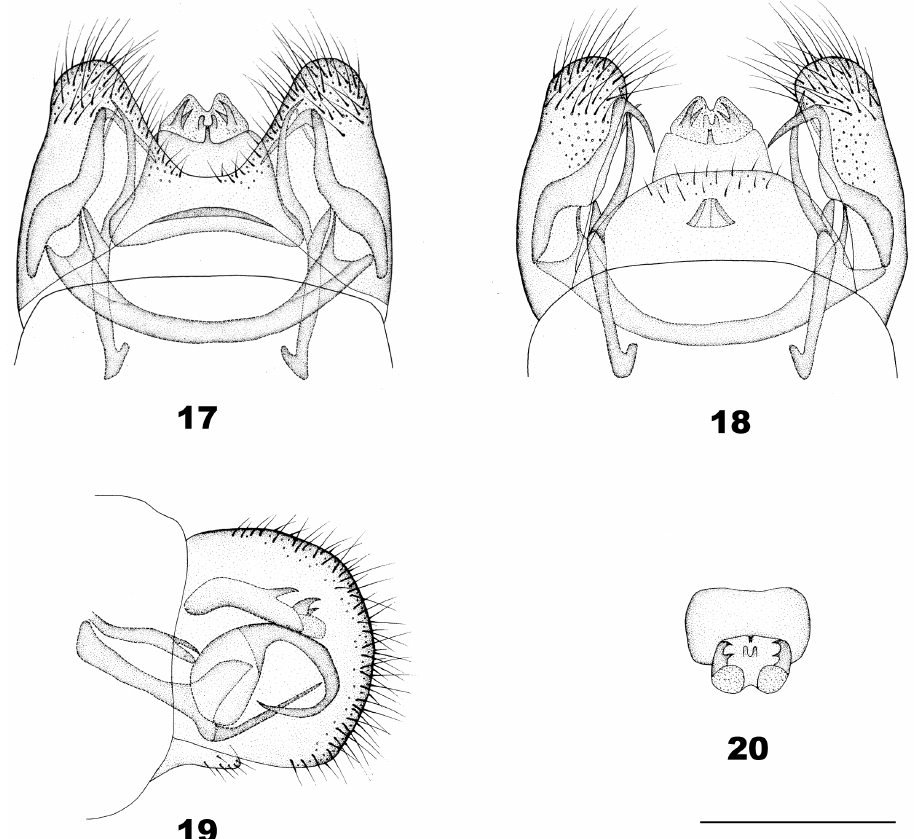
Head yellowish brown, with pale yellow setose tuber- cles. Compound eyes blackish brown. Antenna with ca. 25 segments, pale yellowish brown, medial flagellomeres much longer than those on both ends, distal eight flagel - lomeres short, nearly moniliform. Prothorax pale yellowish brown, pronotum dark brown, with eight yellowish tubercles clothed with yel- lowish hairs; mesothorax and metathorax pale yellowish brown. Legs pale yellowish brown, with each segment blackish brown at tip. Wings hyaline, slightly pale brown, with numerous brownish spots. Forewing ~2.5 times as long as wide, densely spotted, most spots expanded and fused with each other, with markings on costal area and proximal half much darker, arranging as transversely ar- cuate pattern, an immaculate area present distal to median nygmata; two nygmata present on proximal and median portion of forewing, median one much larger than prox- imal one. Hindwing slightly paler than forewing, with similar marking pattern; one nygma present at middle. Veins brown. Forewing with 13 crossveins between Sc and R; Sc just touching R in pterostigmatic region; 12 crossveins between R and Rs; Rs with five main branch - es; MP with two main branches. Hindwing subcostal area slightly widened on distal half, with four crossveins; Rs with six main